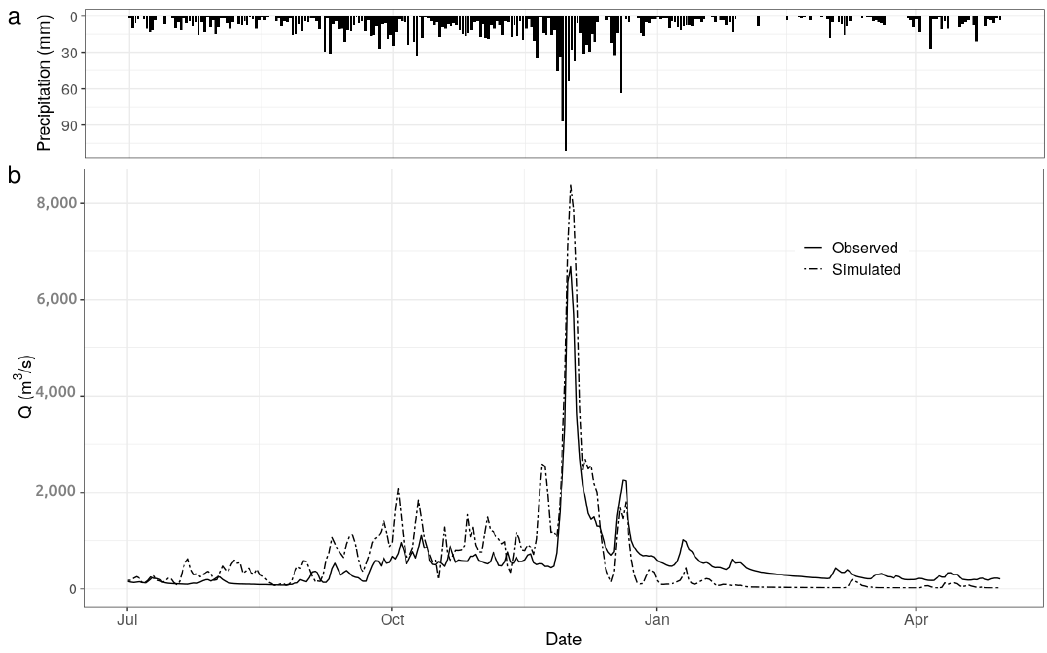
Figure 3. ( a ) The mean areal precipitation, ( b ) The observed and the simulated streamflow of the highest rank parameter